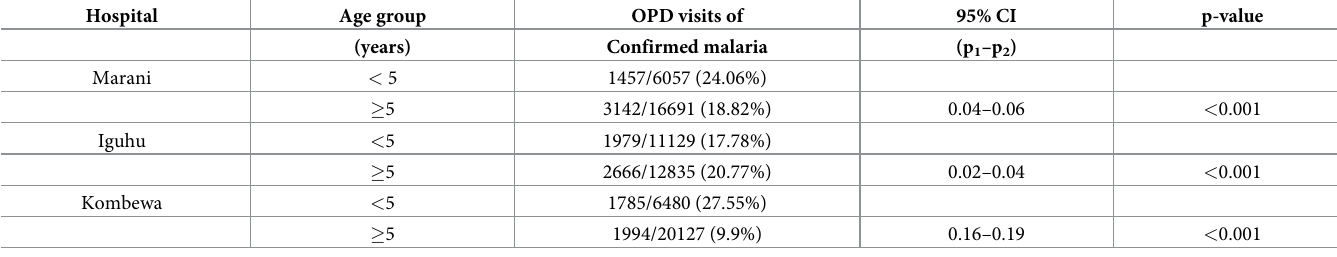
Table 2. Comparison of under-fives and over-fives proportions of confirmed malaria consultations among all outpatients (OPD) of three hospitals located in three areas with different transmission intensity of western Kenya from June 2015 to August 2016.